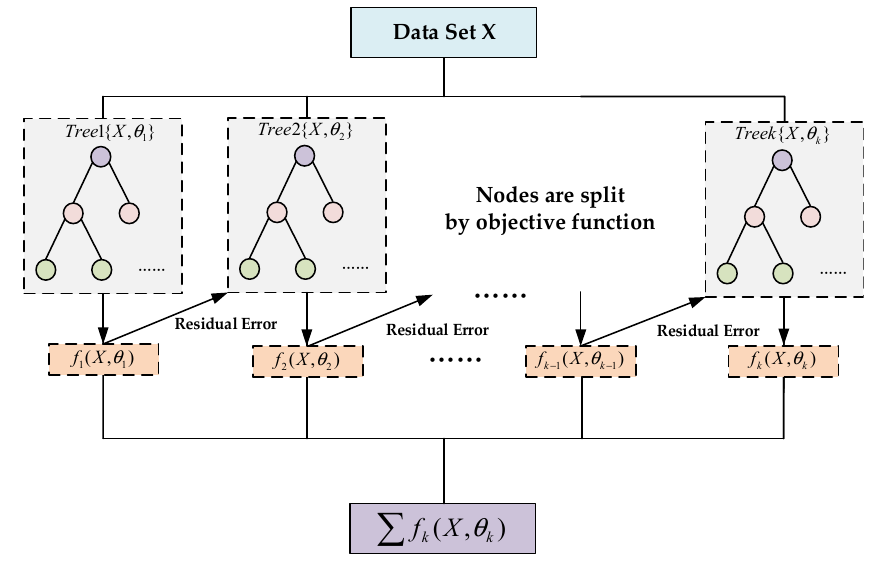
Figure 3. The principle of XGBoost.